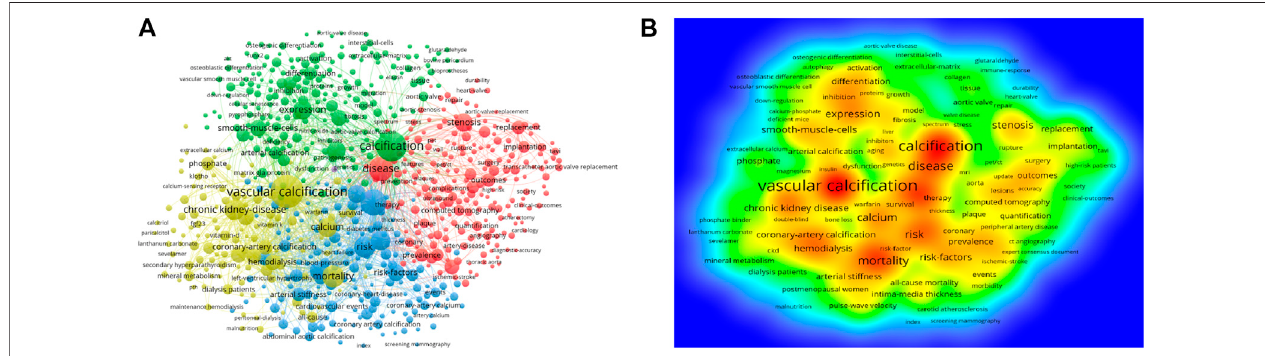
FIGURE 6 | Analysis of all keywords in studies related tovascular calci fi cation research. (A) VOSviewer visualization map of co-occurring keywords. Ofthe 18,983 keywords, 133 had at least 100 co-occurrences. (B) The density map of keywords. The closer the keyword node color is to red, the higher the frequency of its co-occurrence.